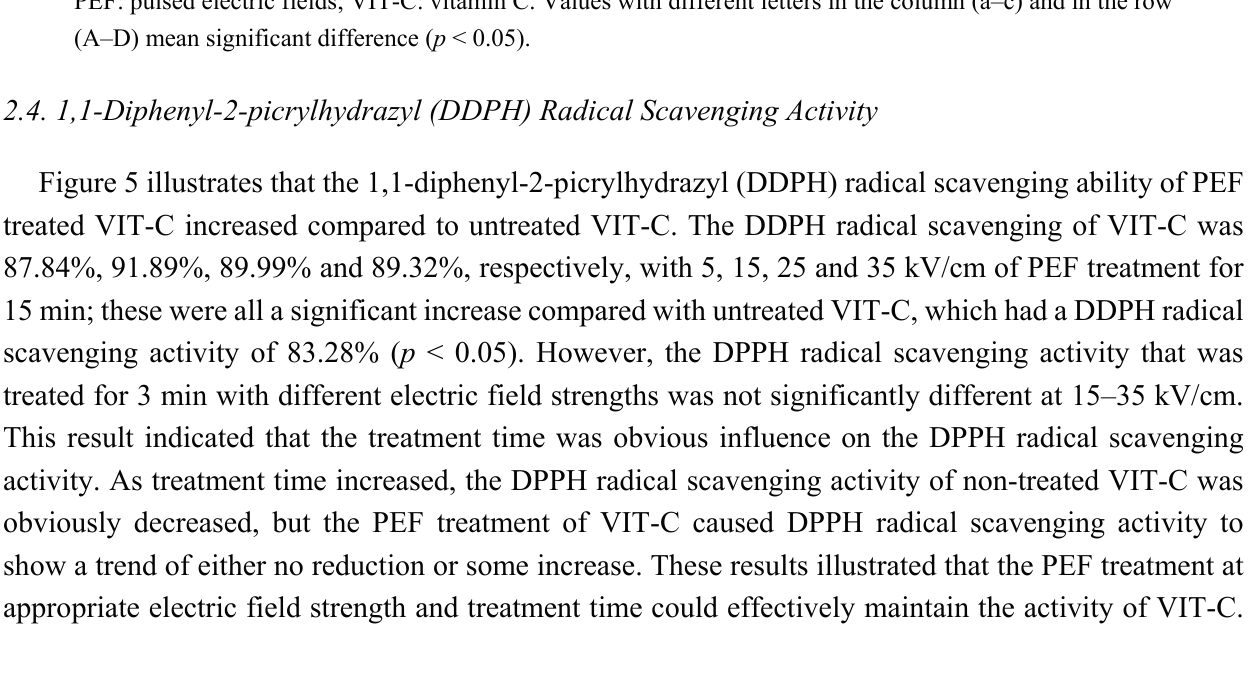
PEF: pulsed electric fields; VIT-C: vitamin C. Values with different letters in the column (a–c) and in the row (A–D) mean significant difference ( p <